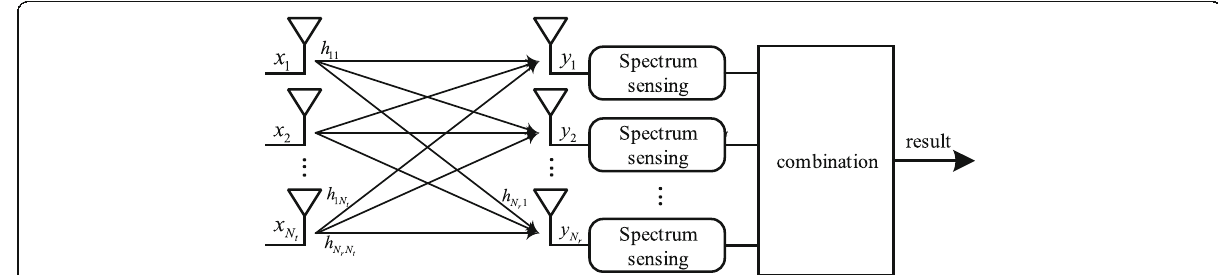
Fig. 2 Pre-combining detection method based on second-order cyclic